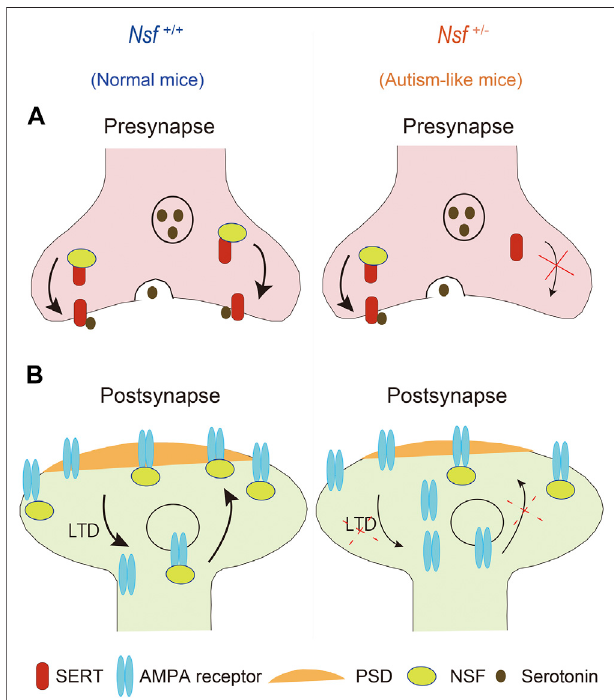
FIGURE 9 | Schematic representation of possible mechanisms through which haploinsuf fi ciency of Nsf causes neurophysiological and behavioral phenotypes similar to autism spectrum disorder via defective membrane traf fi cking of serotonin transporter (SERT) and alpha-amino-3-hydroxy- 5-methyl-4-isoxazole propionic acid (AMPA) receptor in